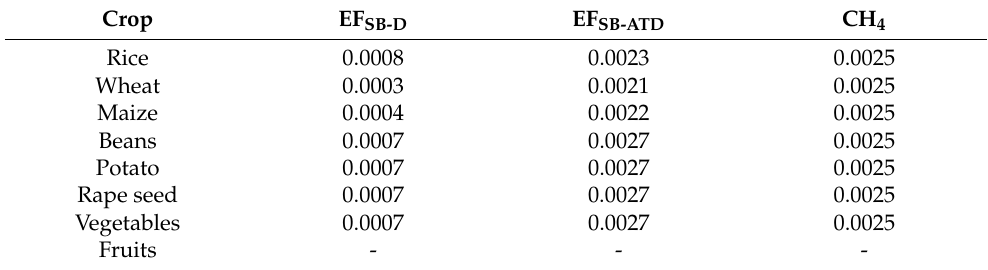
Table A4. Greenhouse gas emissions from straw burning by crops per unit weight. Unit: kg kg − 1 . Crop EF SB-D EF SB-ATD CH 4 Rice 0.0008 0.0023